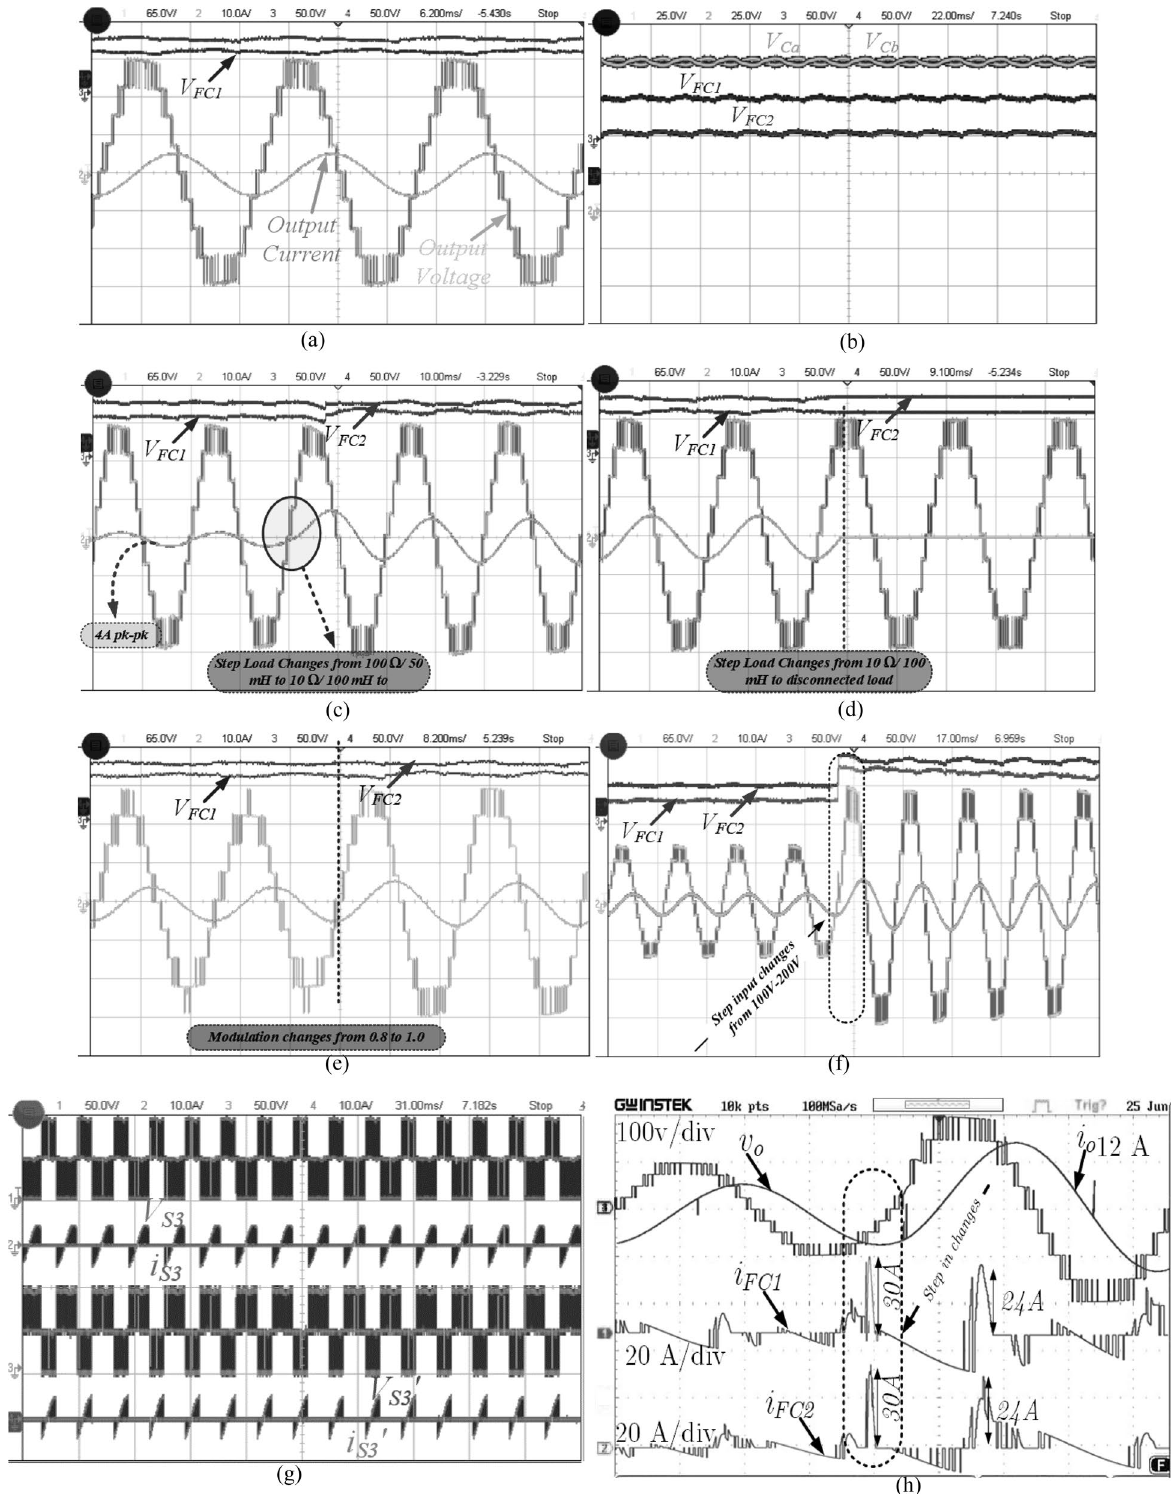
Figure 9. various experimental results of proposed 9L ANPC topology ( a ) output voltage and current for 10 Ω, 100 mH, ( b ) FC and dc-link capacitor voltages, ( c ) load changes from 100 Ω, 50 mH to 10 Ω, 100 mH, ( d ) load changes from 10 Ω, 100 mH to disconnected loads, ( e ) modulation index variation from 0.8 to 1.0, ( f ) the step input voltage changes from 100 to 200 V, ( g ) voltage and current of switch S 3 /S 3 ′ and ( h ) floating capacitor currents during step input voltage